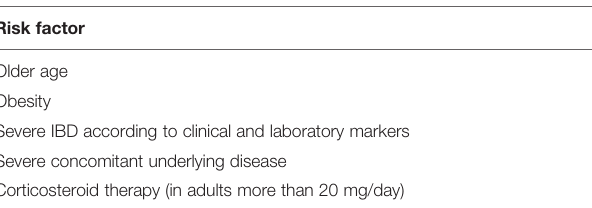
TABLE 1 | Patients with in fl ammatory bowel disease (IBD) at increased risk factors for severe COVID-19 for whom early therapy according to NIH recommendations (40) are